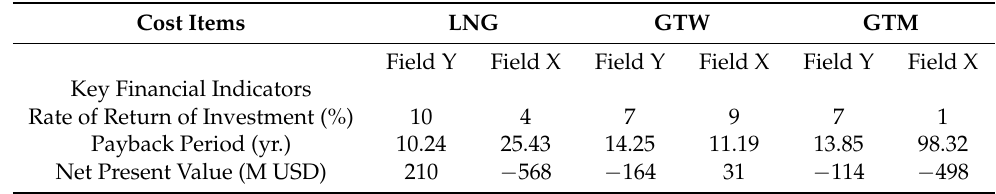
Table 10. Summary of key results for Fields Y and X having a useful lifetime of 25